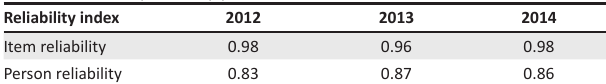
TABLE 2: Reliability index by